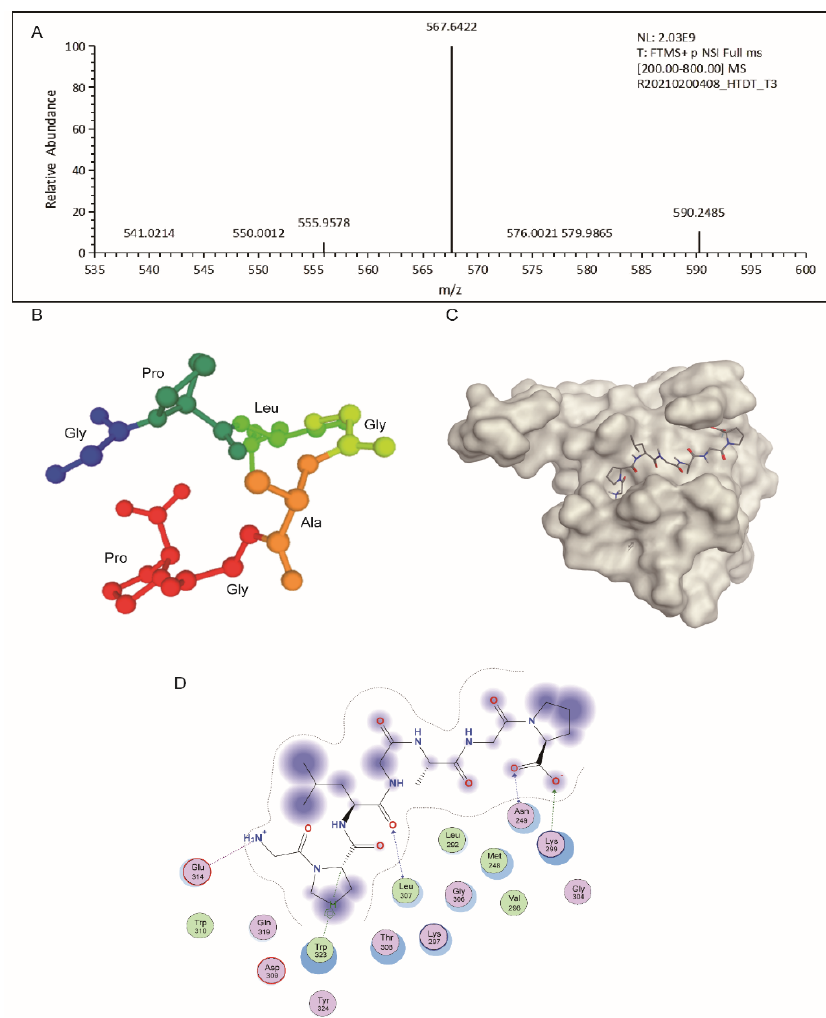
Figure 4. Characterization of HTDT-6-2-3-2. ( A ) MS spectrum result suggested that HTDT-6-2-3-2 bears a m/z of 567.6422, which matched perfectly with the calculated molecular weight of GPLGAGP heptapeptide. ( B ) The three-dimensional structure of HTDT-6-2-3-2 is predicted by PEP-FOLD3. ( C ) Molecular docking simulation of HTDT-6-2-3-2 binding to XIAP showed that HTDT-6-2-3-2 (shown as sticks) could be docked into a shallow pocket in the BIR3 domain of XIAP (gray). ( D ) Interaction between HTDT-6-2-3-2 and XIAP. Asn249, Lys299, Leu307, Glu314, and Trp323 from XIAP were involved in the association with